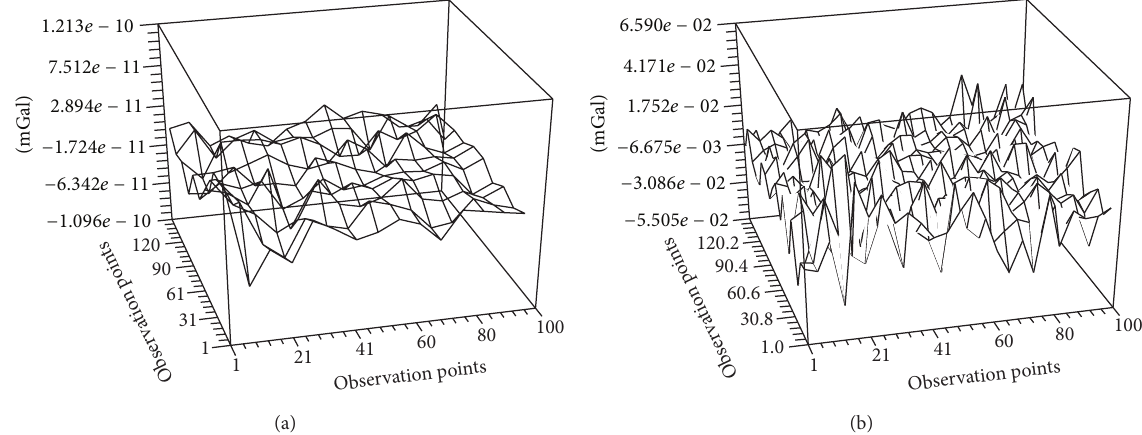
Figure 20: Absolute error of the components 𝐺 𝑧 calculated using four C2070 cards in (a) double precision and (𝑏) single precision with respect to double precision CPU-cluster